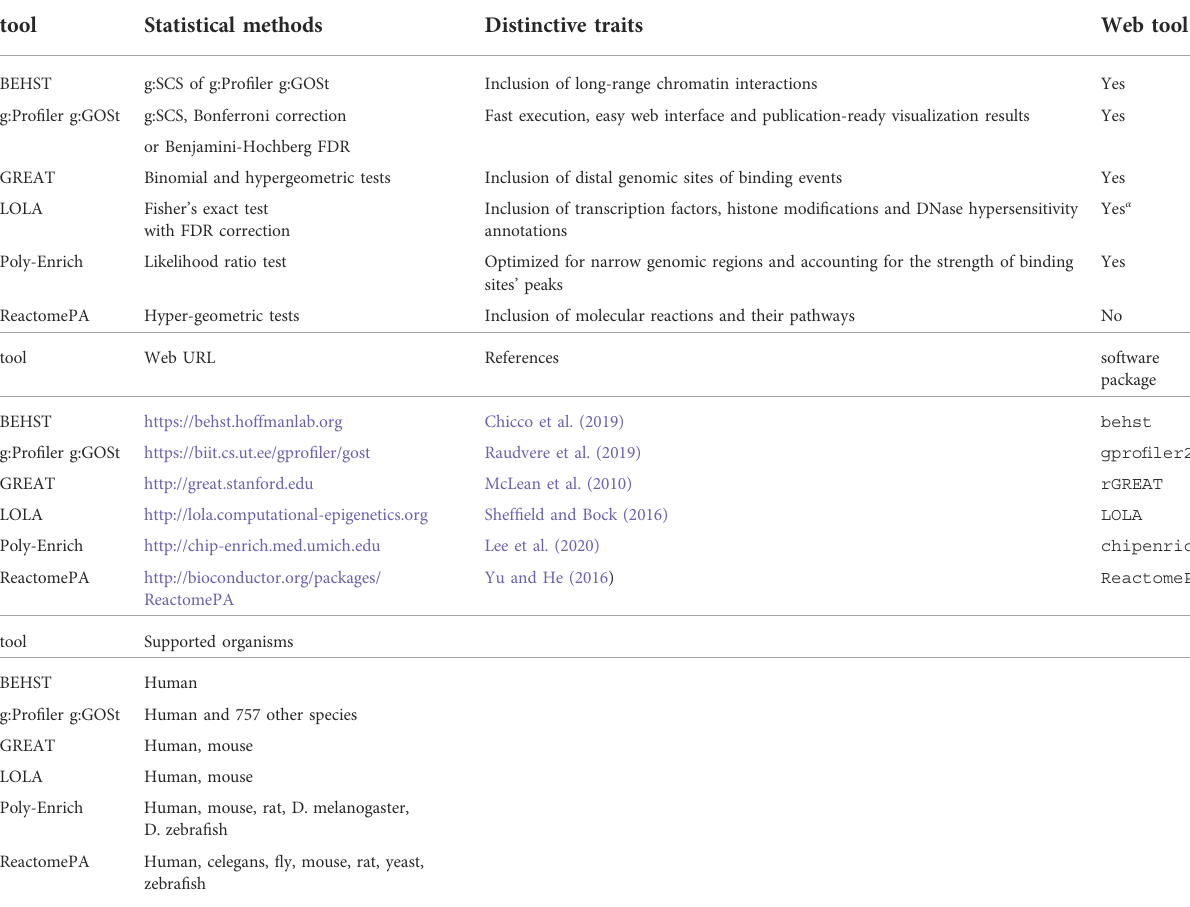
TABLE 1 List of the genomic regions enrichment analysis tools mentioned in this study. We report each tool ’ s name, its statistical methods for the p - valuecalculation,itsdistinctivetraits,itswebURL,itsyear,itsreference,a fi eldstatingwhetheritisavailableaswebtool,anda fi eldindicatingthe name of its standalone software package. FDR: false discovery rate. α : The LOLA web server is called LOLAweb (Nagraj et al., 2018). g:SCS is the statistical method for adjusted p -value calculation employed by g:Pro fi ler g:GOSt by default (g:Pro fi ler g:GOSt, 2022). The article by Raudvere et al. (2019) refers to the latest update of g:Pro fi ler; its original release and previous updates were described in past studies (Reimand et al., 2007, 2011, 2016; Kolberg et al., 2020). The bottom table contains the lists of the supported organisms of the data for each